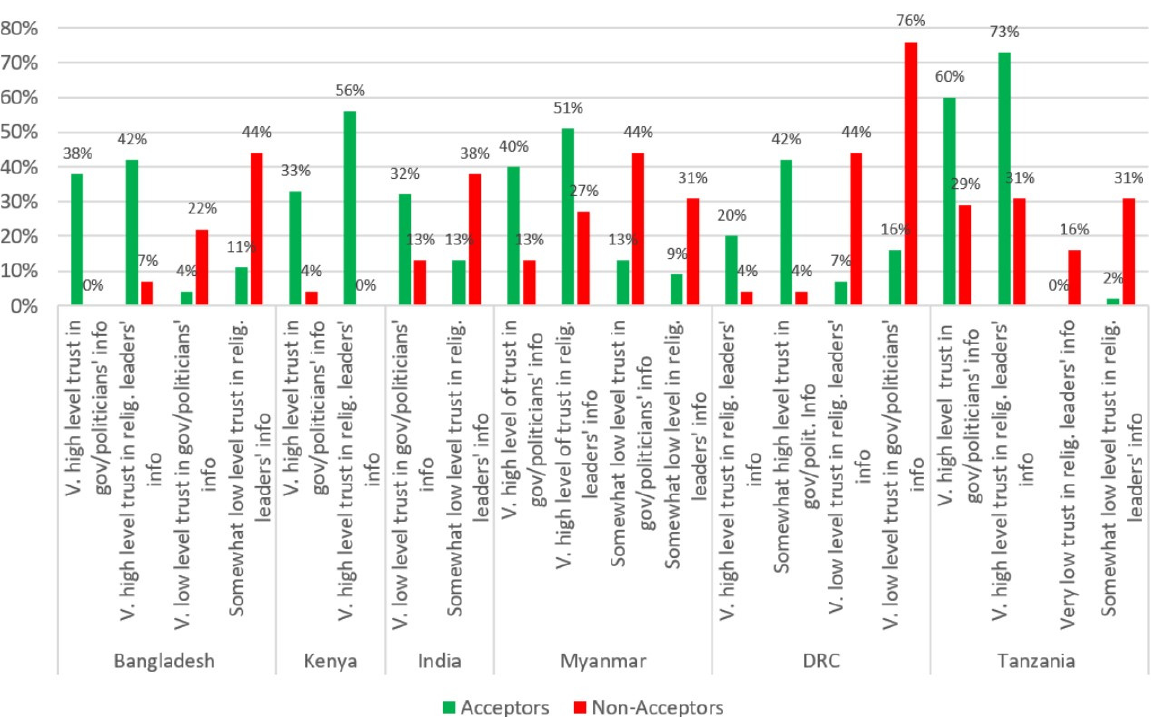
Figure 4. Acceptors’ and Non-acceptors’ beliefs on the safety of getting a COVID-19 vaccine by country.